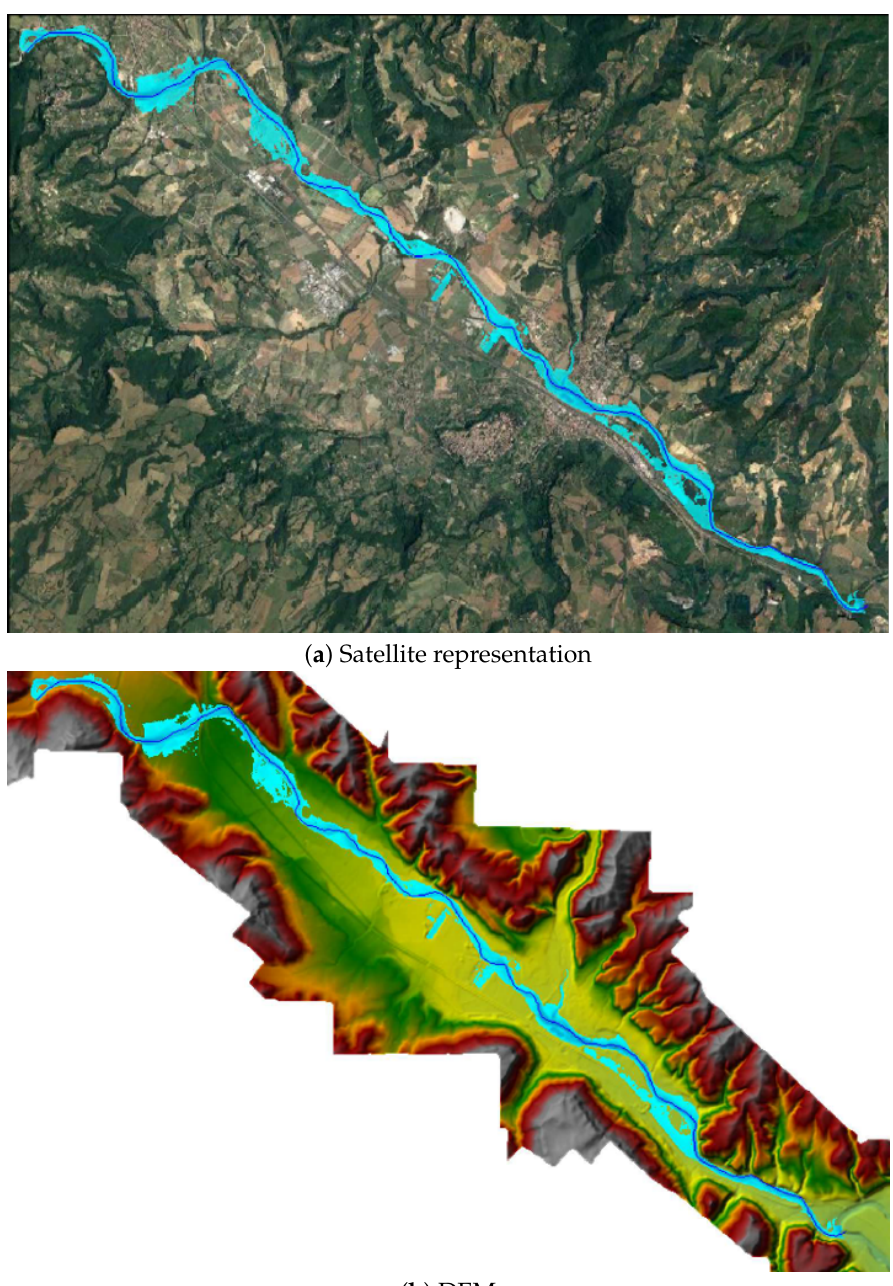
Figure 3. Satellite ( a ) and DEM ( b ) representations of the simulated overflow